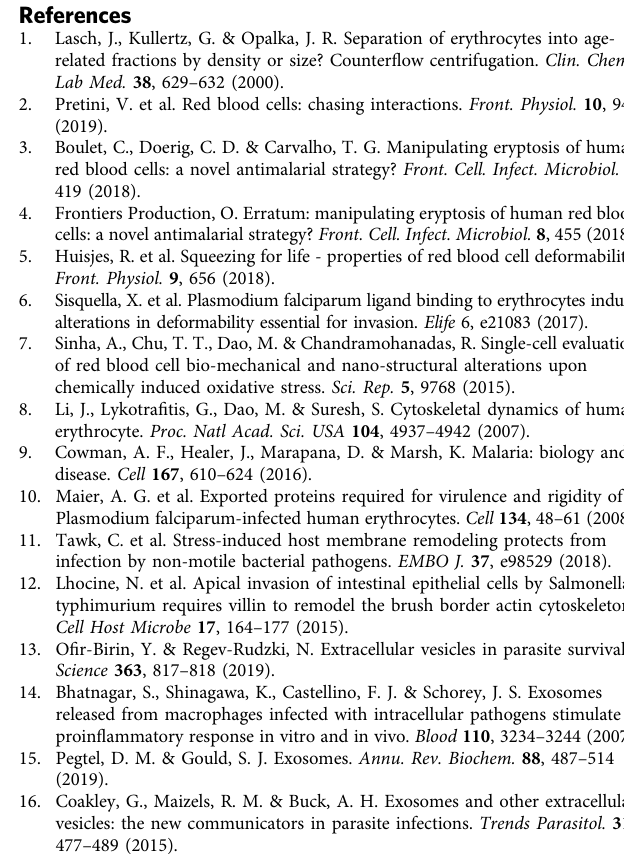
Figure preparation . Graphs were prepared using Graphpad PRISM v.8 and Microsoft Of fi ce Excel 2016. Figures were prepared using Adobe Illustrator CS3